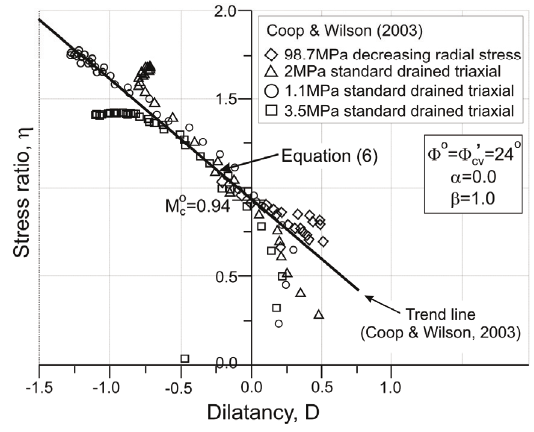
Fig. 7. Stress-dilatancy relationship for Reservoir Sand-C